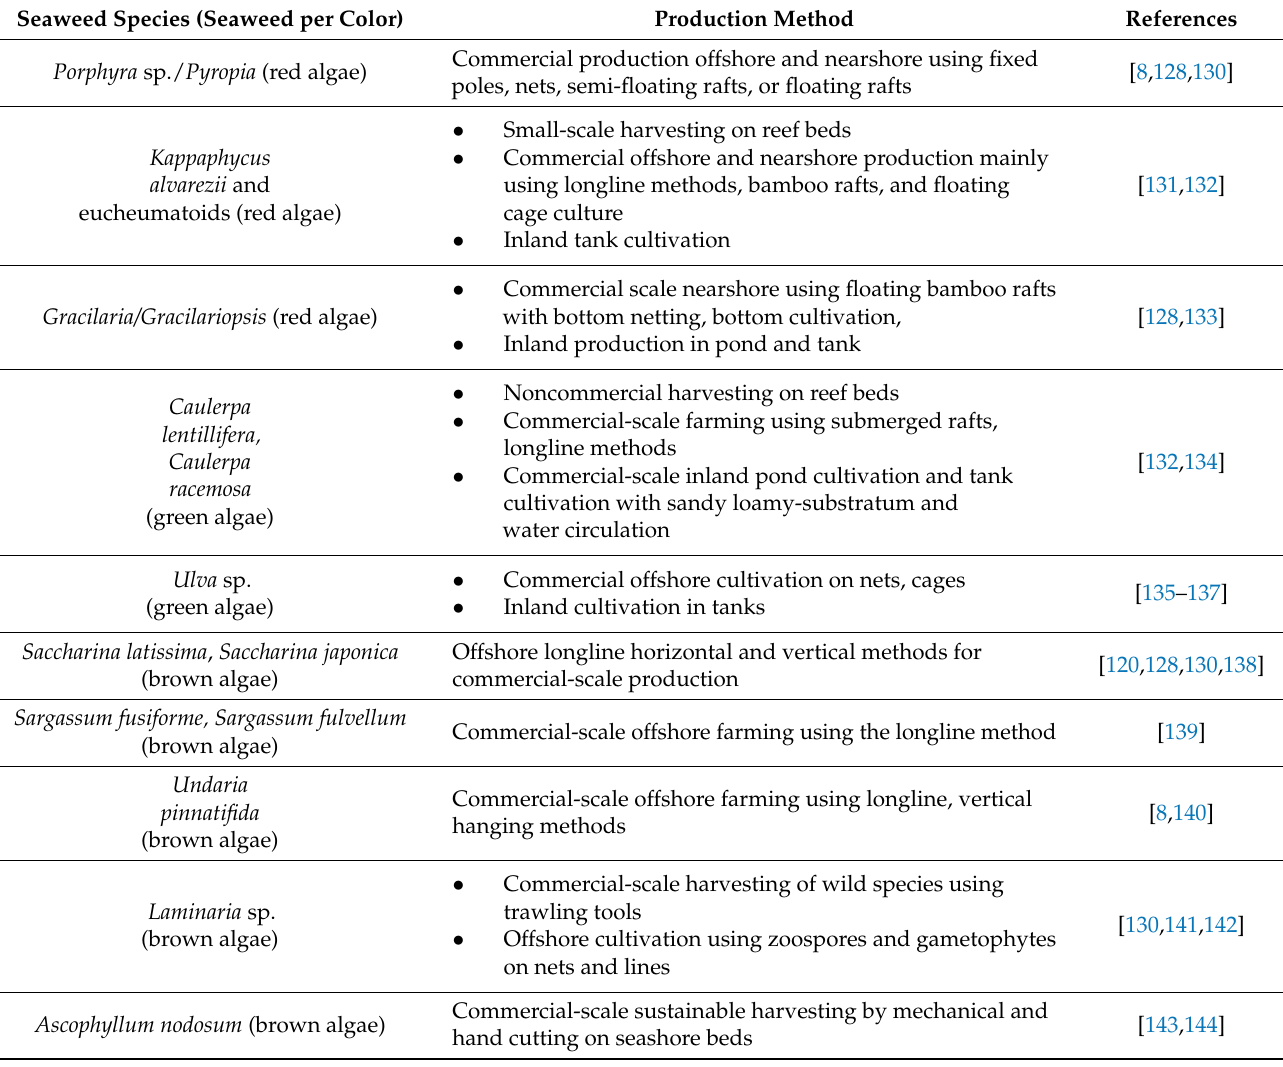
Table 1. Single-crop farming and harvesting system of some commercial